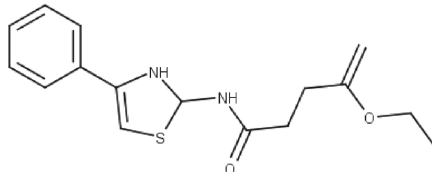
FIGURE 15 - Derivative 2-aminotiazole that can act on PARP-1 enzymes and